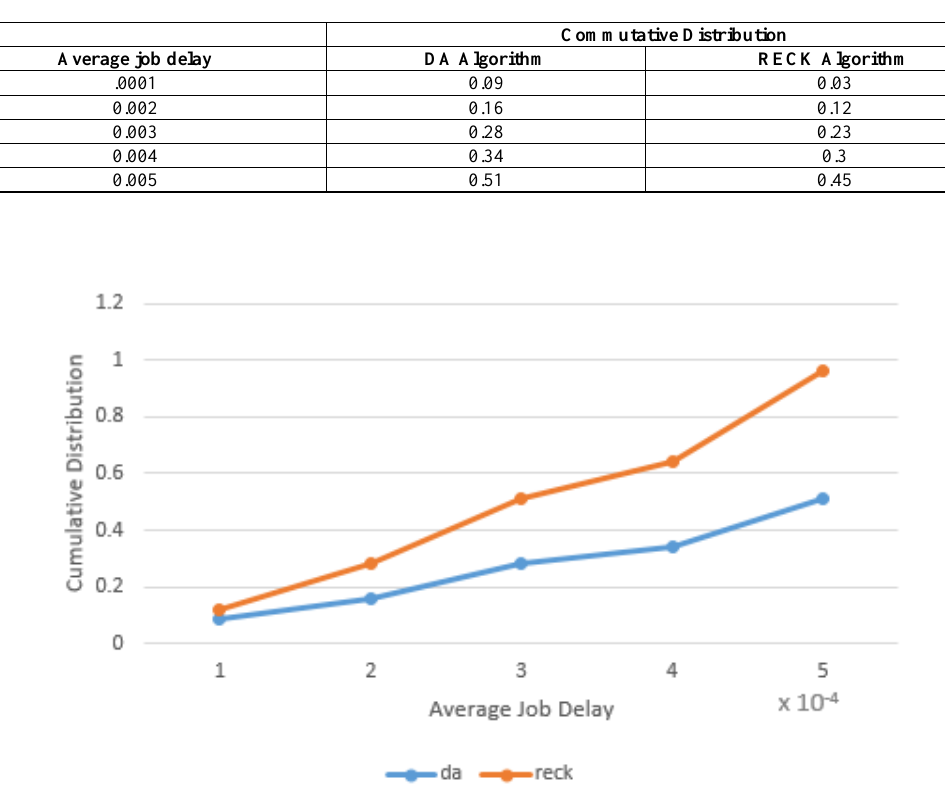
Table 3. Highlights the data of DA and RECK algorithm on the basis of average job delay